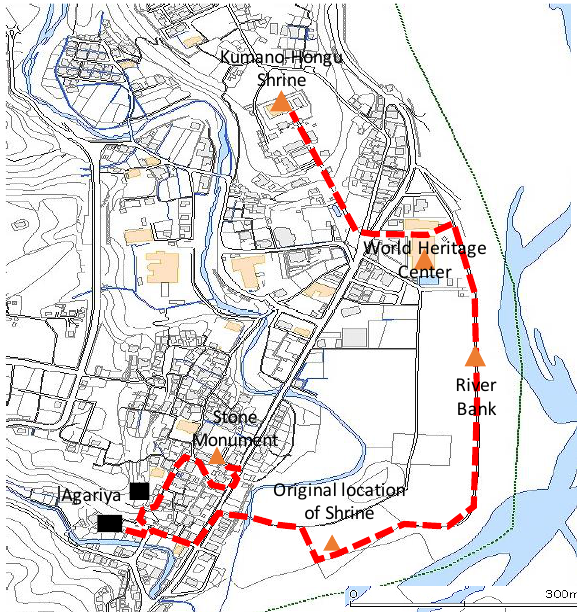
Figure 10. The rout of visiting the disaster remains.